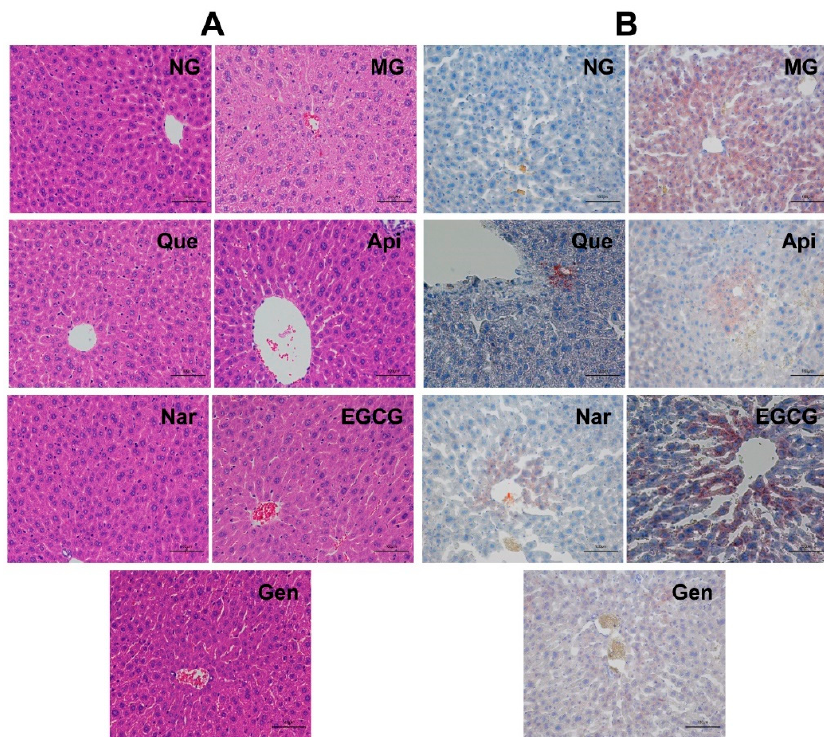
Figure 7. Histopathological detection of livers. Typical photomicrographs of liver sections at a magnification of 200 × were stained with hematoxylin and eosin ( A ) and oil red O ( B ). All the bars represent 100 µ m. NG, normal group; MG, model group; Que, quercetin; Api, apigenin; Nar, naringenin; EGCG, epigallocatechin gallate; Gen, genistein.